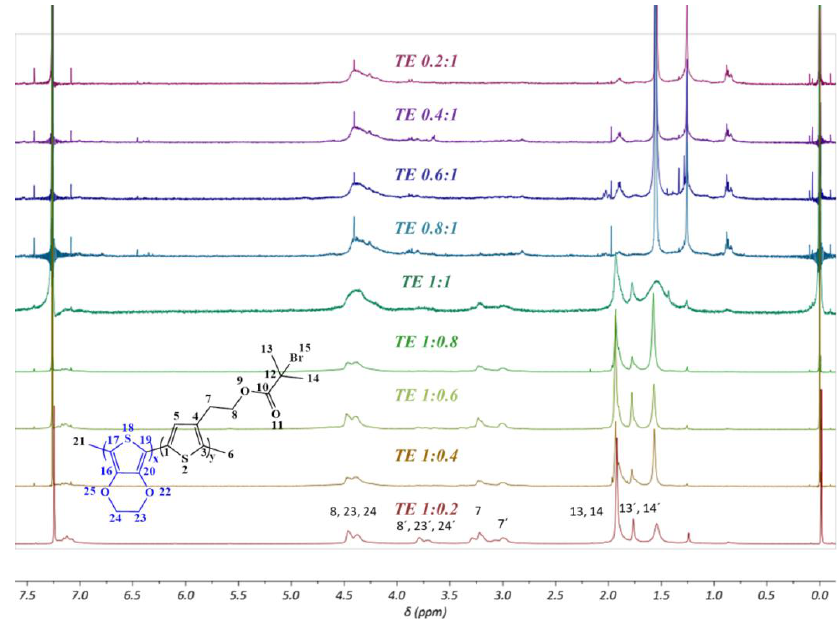
Figure 10. 1 H NMR spectra of products with different monomer ratios. Table 3. Starting monomer ratios and final monomer ratios determined by NMR.